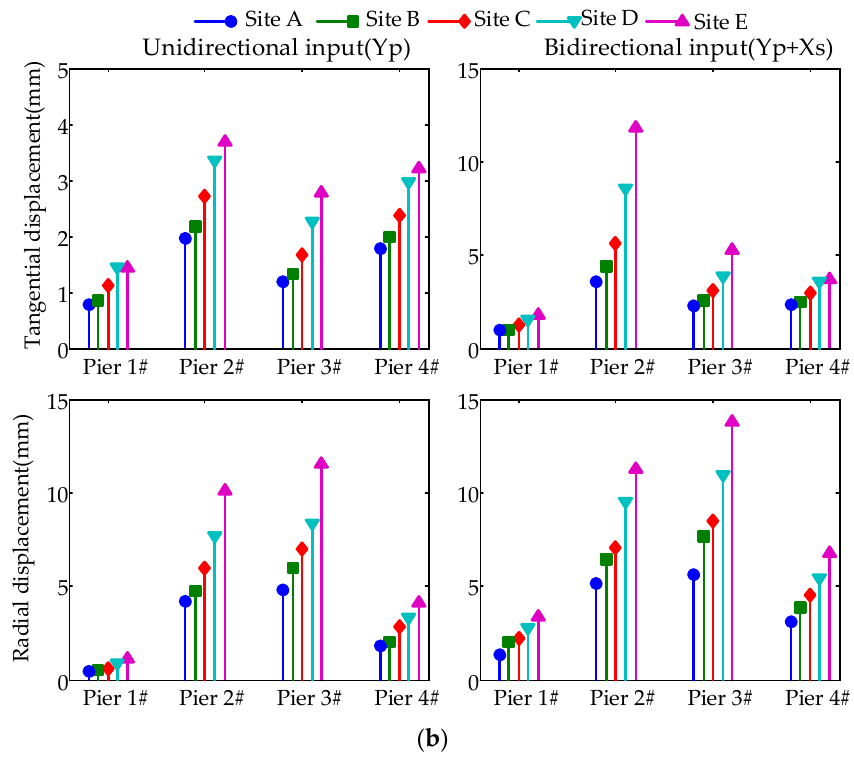
Figure 12. Pier top displacement response peak: ( a ) position A, curved bridge parallel to the direction of the principal ground motion; ( b ) position B, curved bridge perpendicular to the direction of the principal ground motion.